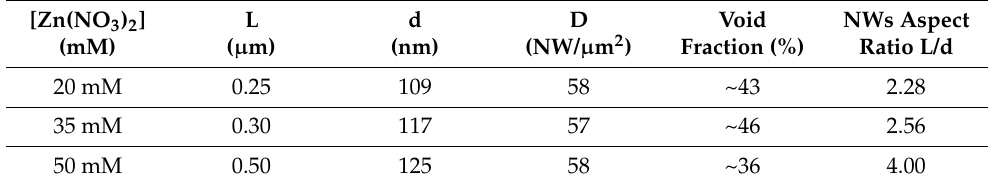
Table 5. Summary of the length, diameter, apparent density, and void fraction of ZnO NWs as a func- tion of the concentration of zinc salt [Zn(NO 3 ) 2 ] ([Zn 2+ ]/[PEI] = 4.5; [Zn 2+ ]/[HMTA] = 1.33, growing time of 6 h). For the HMTA and PEI concentration values for different [Zn(NO 3 ) 2 ] concentrations, see Table S3.